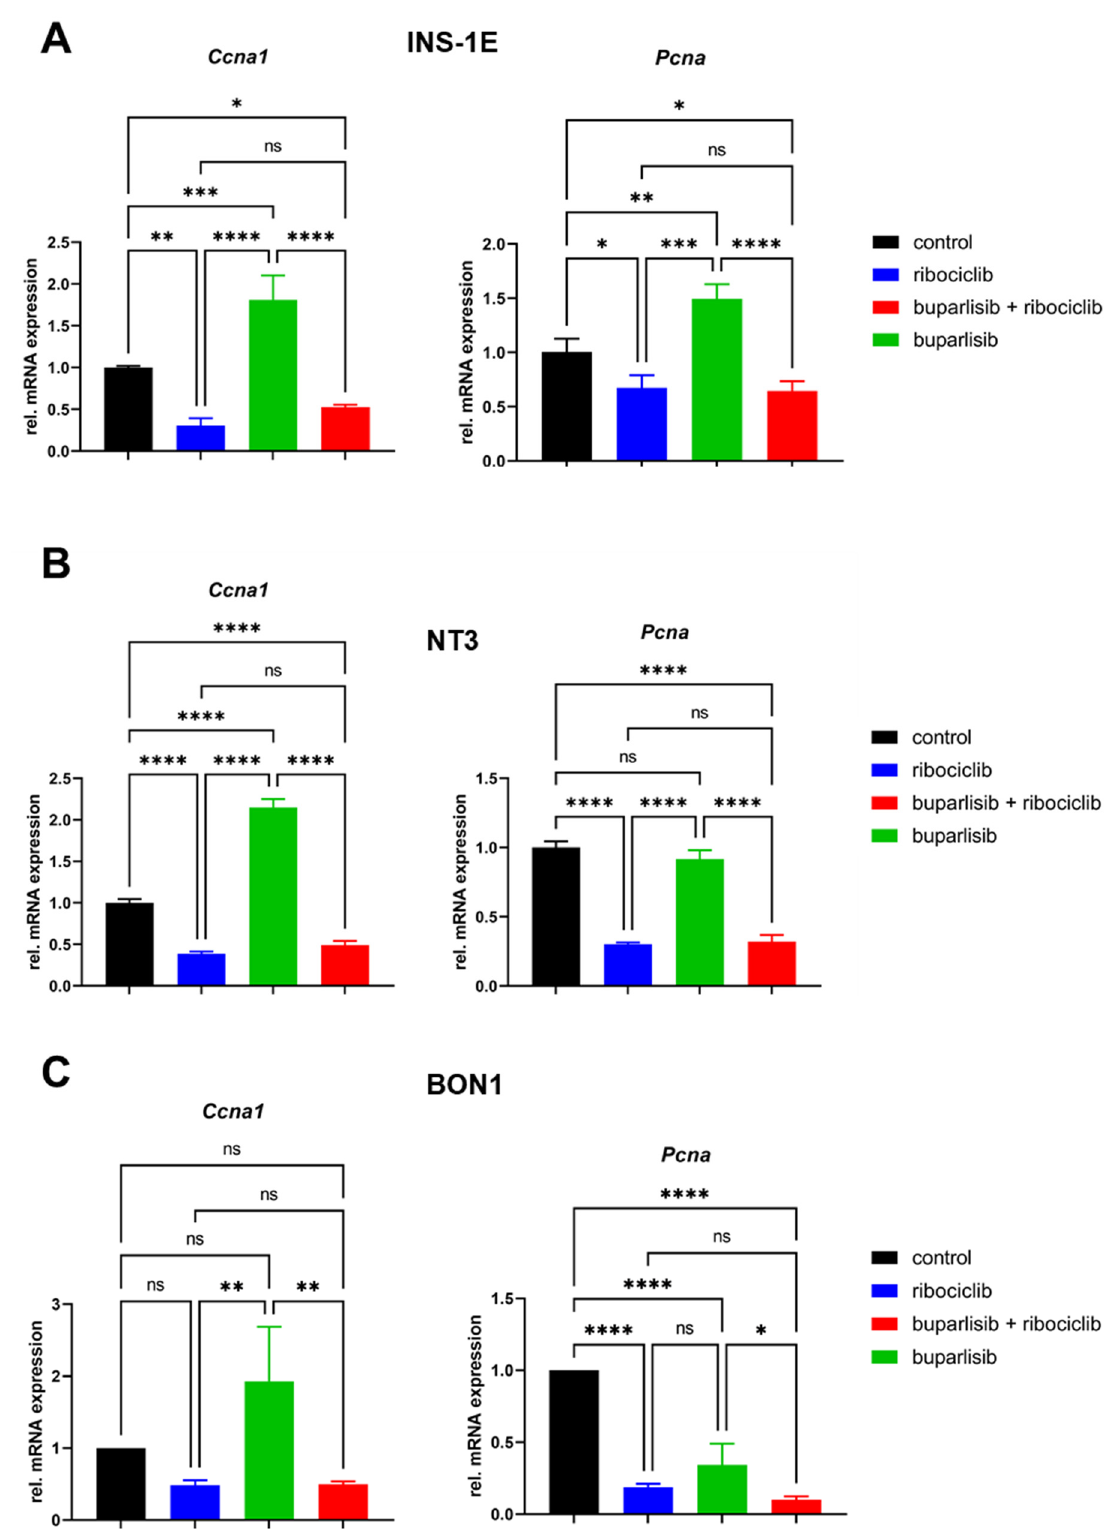
Figure 4. Inhibition of targets of CDK4/6 confirmed by qRT ‐ PCR. Expression of Ccna1 (cyclin A) and Pcna in INS ‐ 1E ( A ), NT ‐ 3 ( B ) and BON ‐ 1 ( C ) cells 72 h after treatment with the indicated drugs. qRT ‐ PCR was carried out using specific TaqMan probes and data were normalized against vehicle control. The mean ± SD of three independent biological replicates is shown. ns, not significant; *, p < 0.05; **, p < 0.01; ***, p < 0.001; ****, p < 0.0001 (by 1way ANOVA).